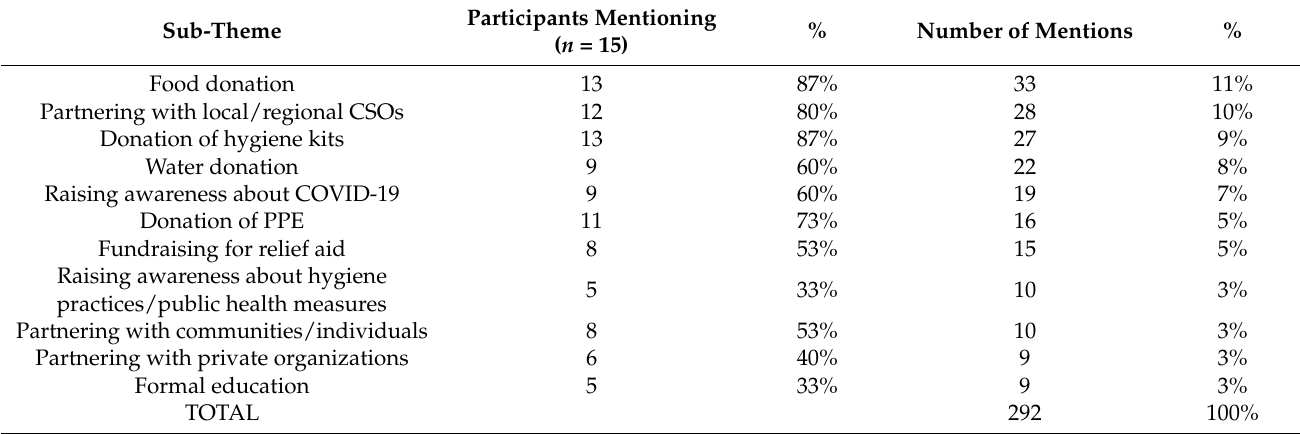
Table 5. CSO initiatives during the COVID-19